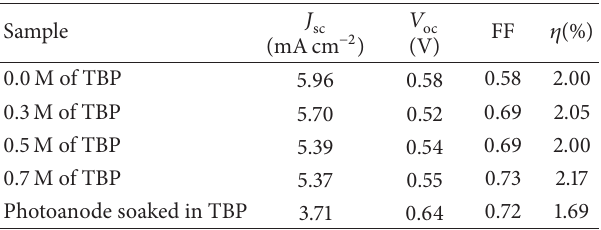
Table 4: Performance parameters of DSSCs with double salt PVA electrolyte containing various amounts of TBP and that of the DSSC with photoanode soaked in TBP for 1h.